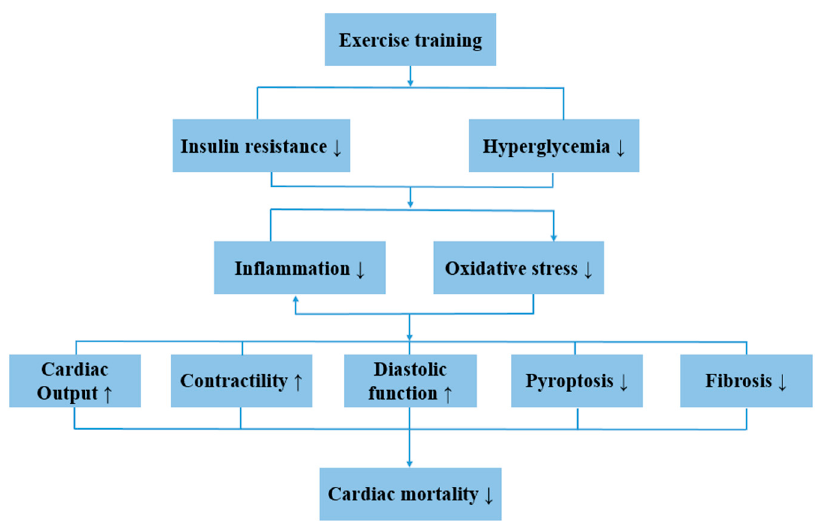
Figure 3. Schematic summary of the effect of exercise training on DCM. Exercise training causes alleviation of hyperglycemia and insulin resistance, which result in improvements of system and cardiac inflammation as well as reduced oxidative stress level. Therefore, cardiac output, cardiac contractility and diastolic function are improved, and pyroptosis and cardiac fibrosis are rescued.